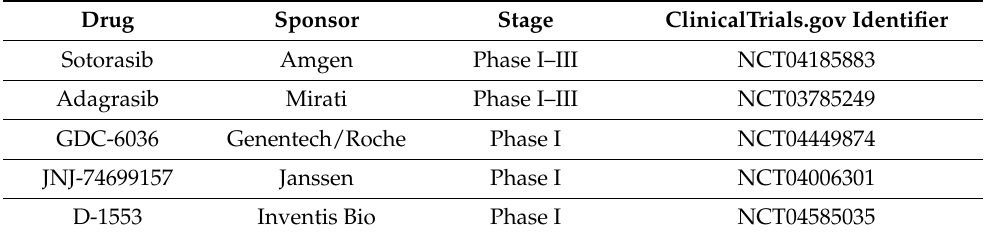
Table 1. TKIs KRAS G12C Inhibitors in Clinical